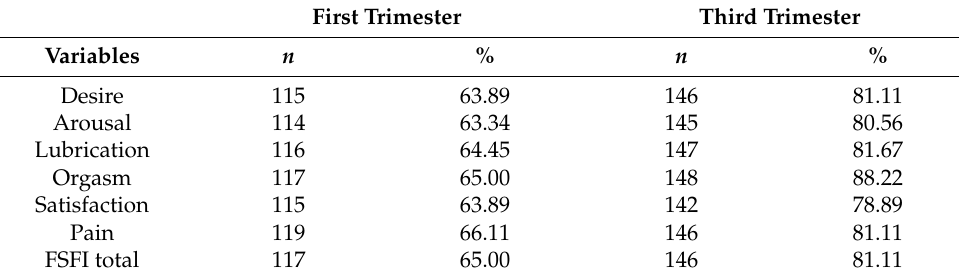
Table 3. Frequency and percentage of dysfunctionality risk by FSFI scales.